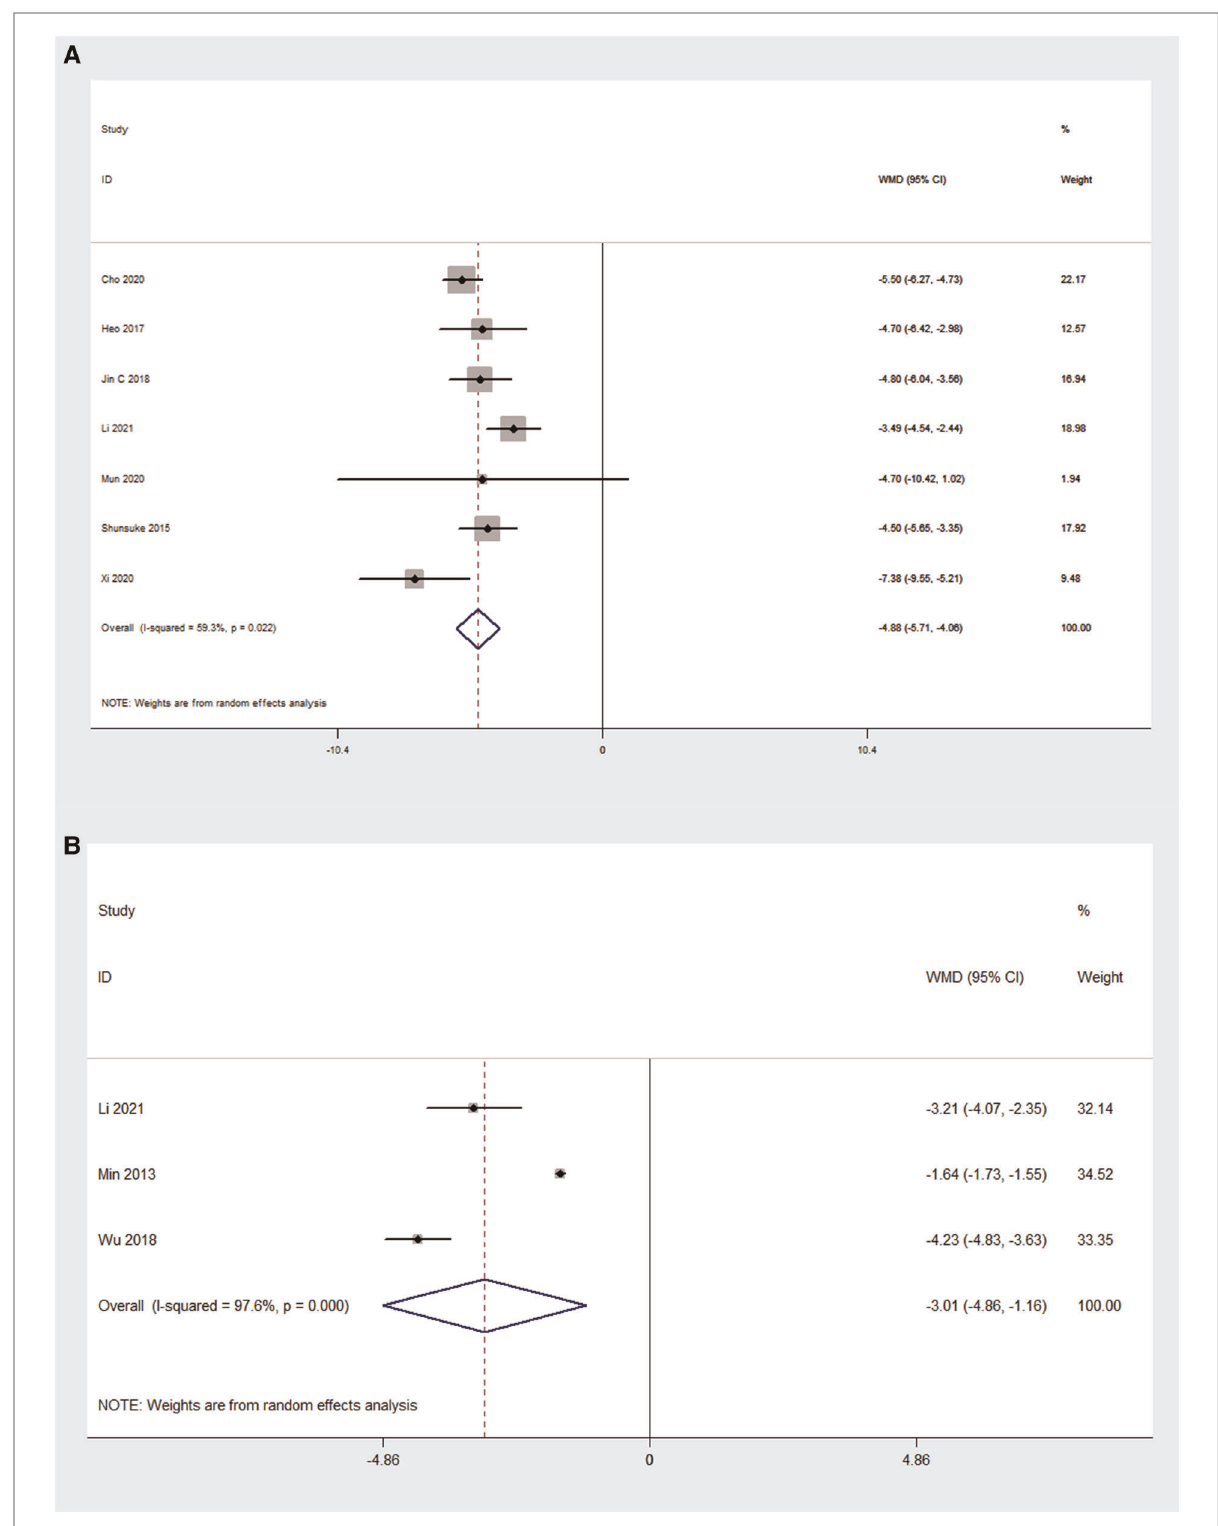
FIGURE 5 Forest plot and pooled estimates of disk height. Outcomes assessed are ( A ) OLIF group; ( B ) MI-TLIF